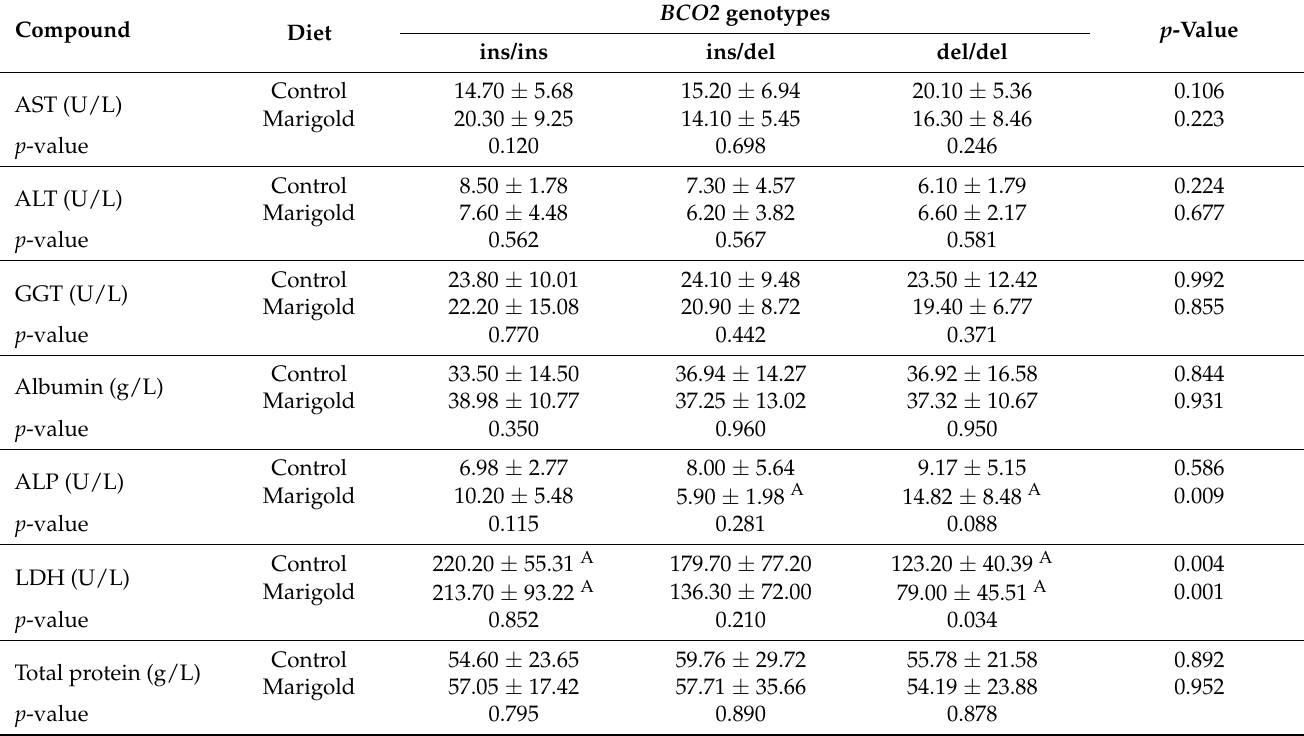
Table 3. Blood plasma biochemical parameters of rabbits (mean ±